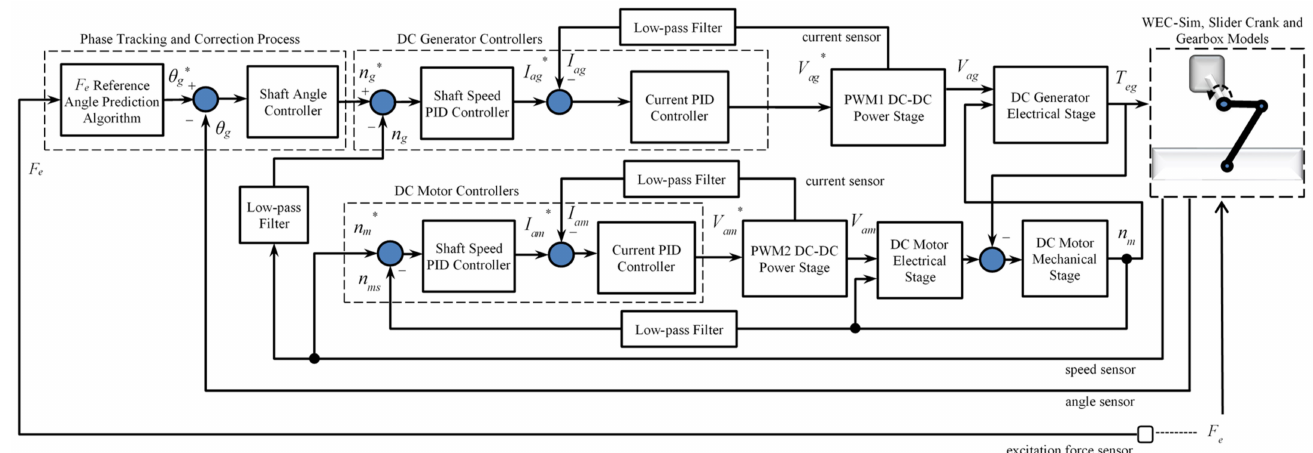
Figure 6. Control system block diagram for the HIL